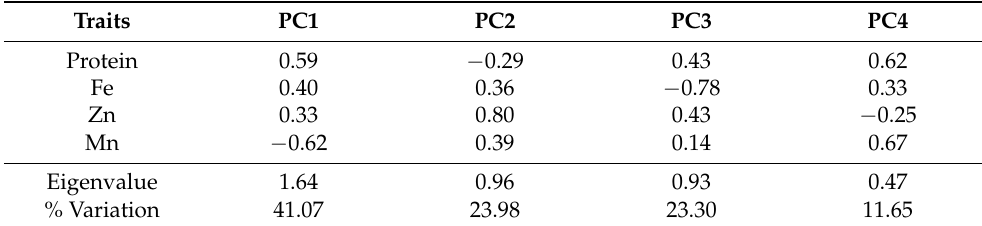
Table 8. Eigenvectors from principal component (PC) analysis for cowpea genotypes on protein, iron (Fe), zinc (Zn), and manganese (Mn)